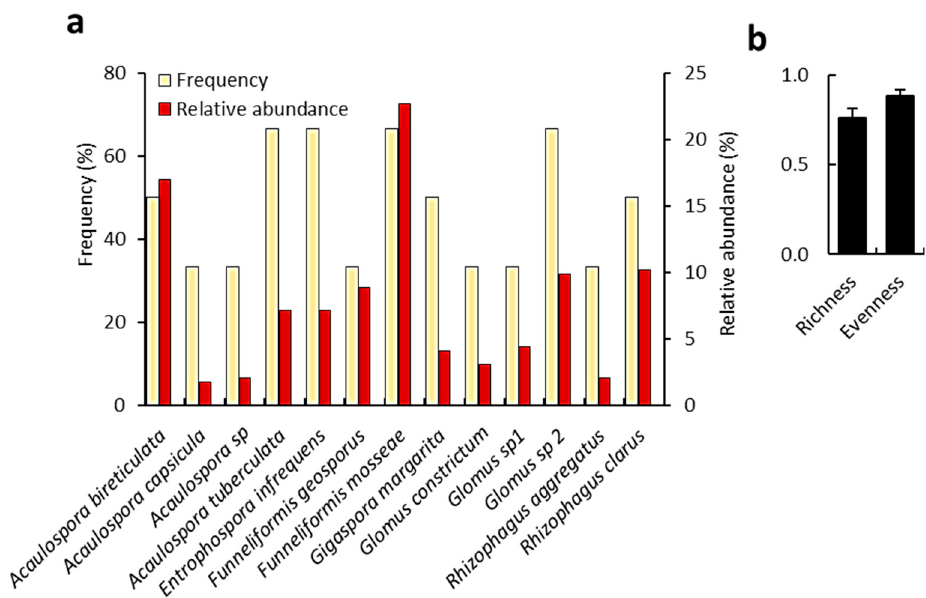
Figure 6. Diversity analyses of mycorrhizal fungi in the rhizosphere soil of C. polygonoides . ( a ) frequency and relative abundance. ( b ) Species diversity indexes (richness and evenness).